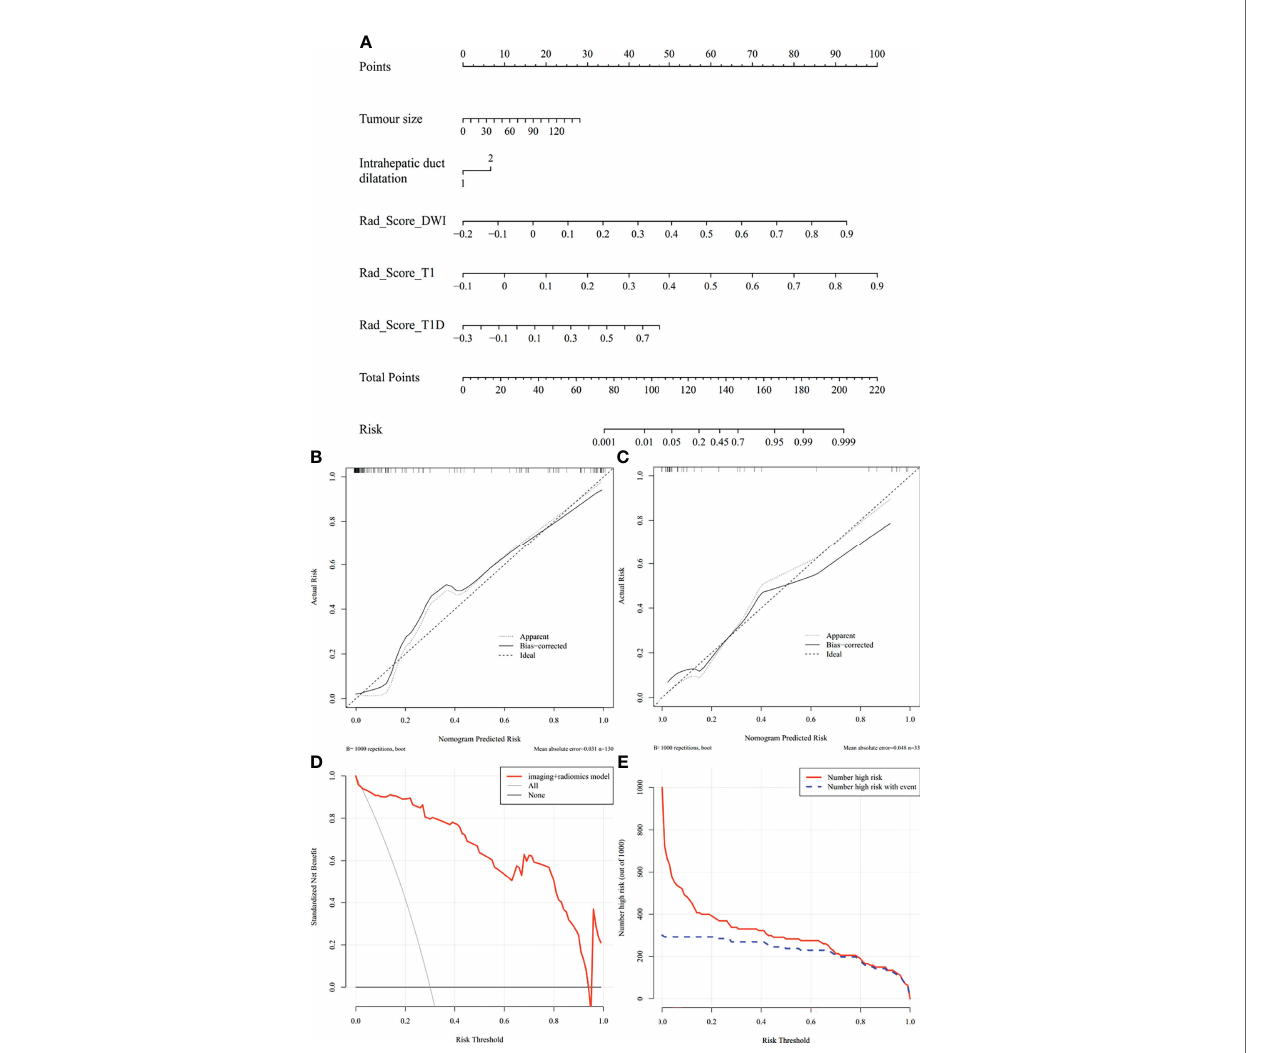
FIGURE 5 | Nomogram of MVI prediction model, calibration curves of the nomogram in the training and validation cohort, decision curve, and clinical impact curve in the overall ICC patients. (A) A nomogram integrates imaging factors including tumor size and intrahepatic duct dilatation, and radiomics factors includes Rad- scores of diffusion-weighted images, precontrast T1-weighted images, and delayed phase images. (B, C) Calibration curves of the nomogram in the training and validation cohort. x -axis is a nomogram-predicted risk of MVI. y -axis is actual risk of MVI, and the diagonal dashed line indicates the ideal prediction by an ideal model. (D) Decision curve for the nomogram in the overall patients. The gray line is the net bene fi t of assuming that all patients have MVI; the black line is the net bene fi t of assuming no patients have MVI; and the red line is the expected net bene fi t of per patient based on the nomogram. (E) Clinical impact curve for the nomogram in the 1,000 simulated samples. The blue dashed line is the actual number of high risk, and the red line is the number of high risk based on